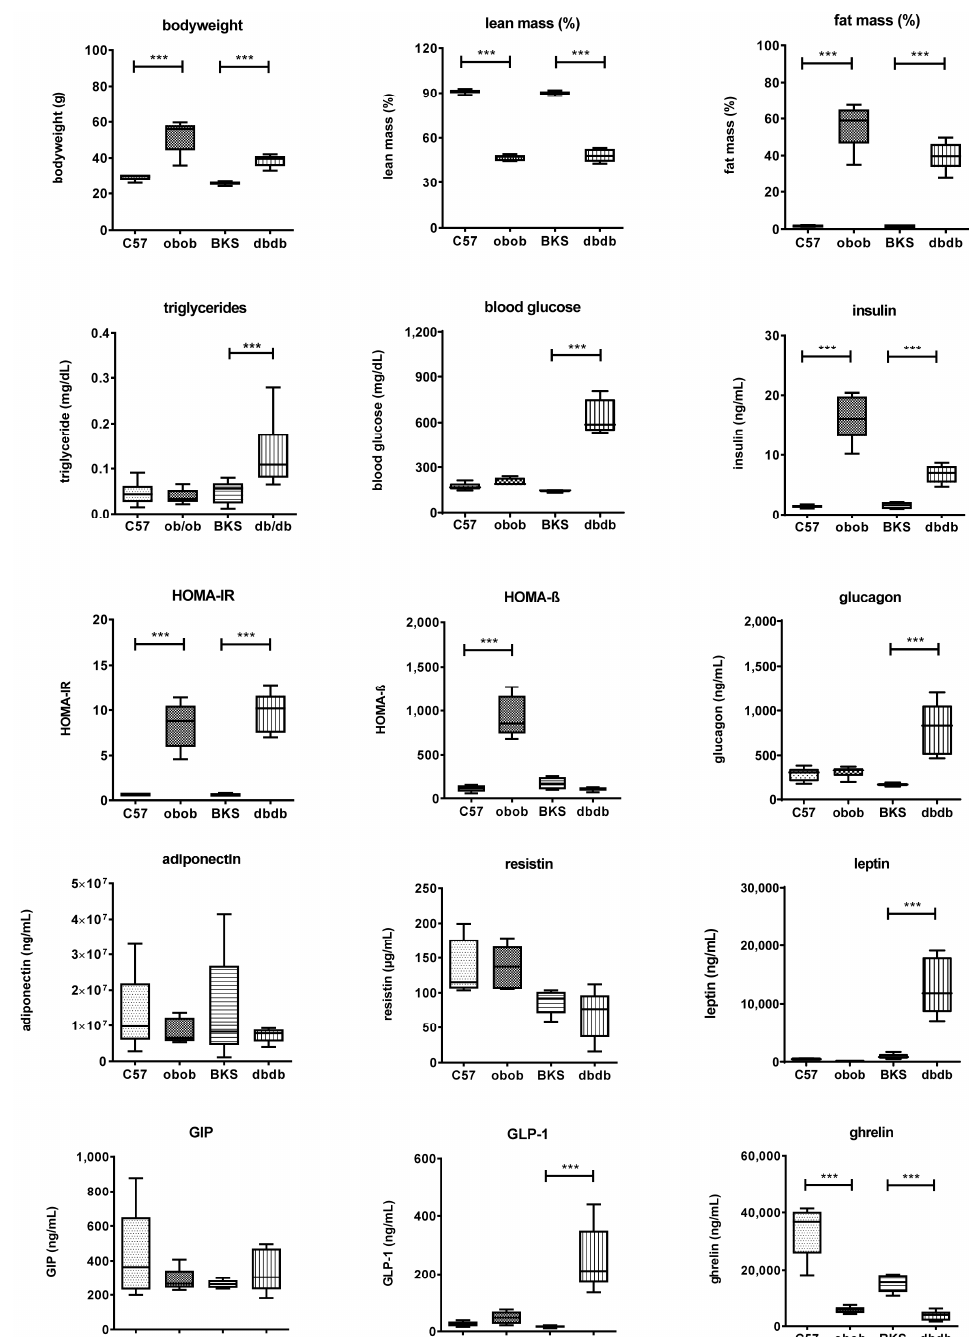
Figure 1. Metabolic characterization of C57, BKS, obob and dbdb mice used in the study. Data are expressed as mean ± SD ( n = 8 of each phenotype). *** p < 0.001 by Student’s t test.